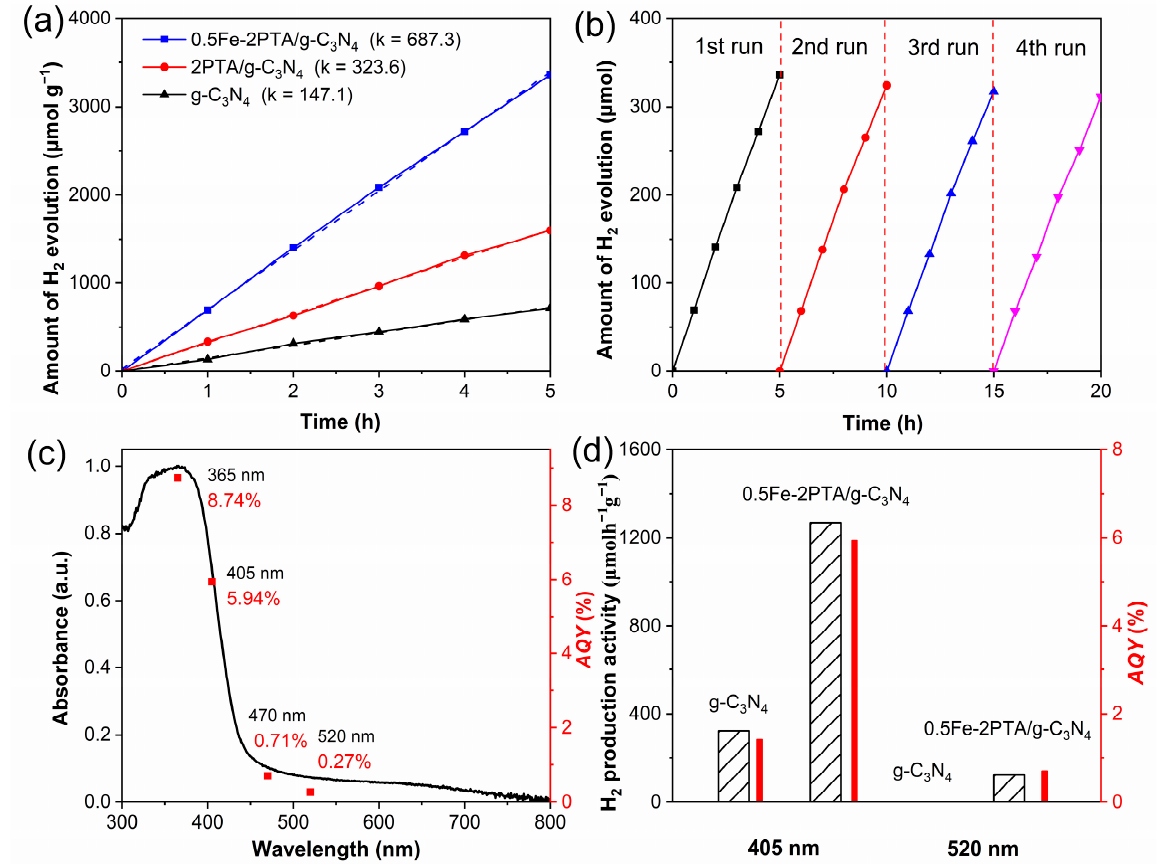
Figure 6. ( a ) Photocatalytic activities of water reduction for H 2 evolution under irradiation with visible light. ( b ) Stability of H 2 evolution amounts over 0.5Fe-2PTA/g-C 3 N 4 . ( c ) Wavelength-dependent AQY values and DRS spectrum of 0.5Fe-2PTA/g-C 3 N 4 . ( d ) Photocatalytic activities for H 2 evolution at di ff erent excitation wavelengths (k is the rate constant of zero-order reaction for H 2 production with the same meaning, unless stated elsewhere).